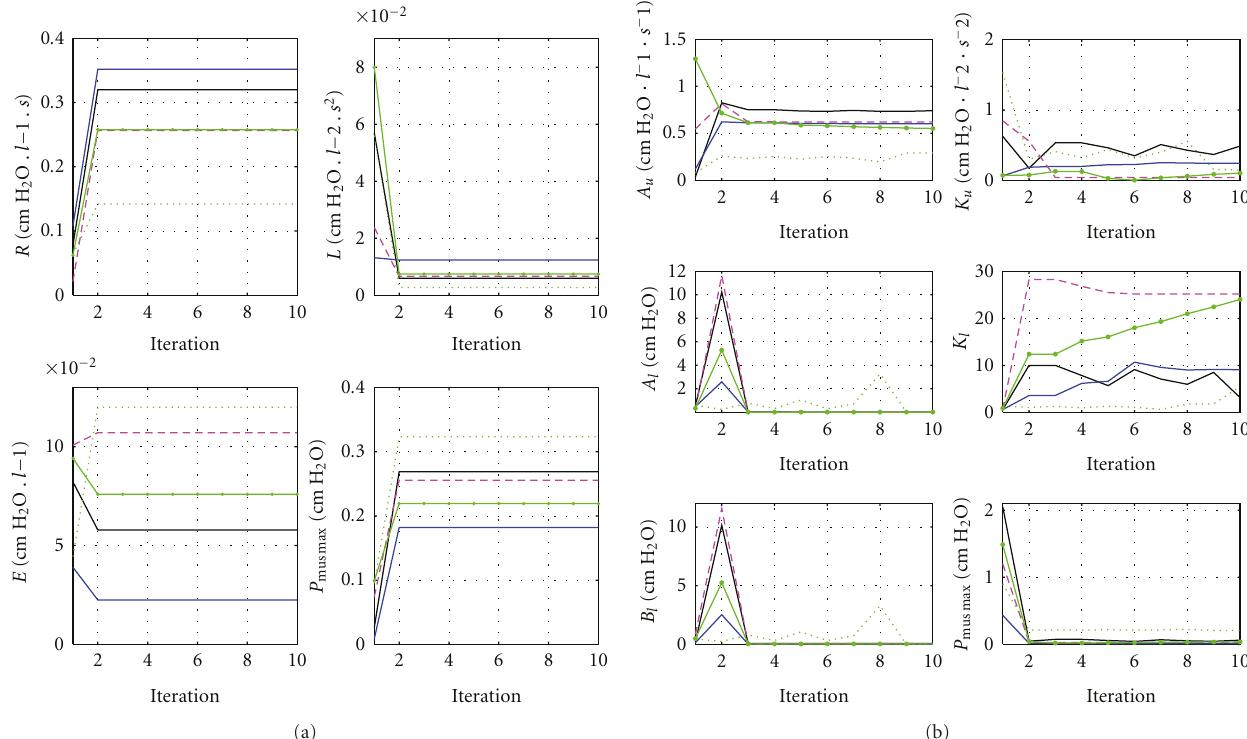
Figure 9: (a) Linear RIC model parameter estimation for five di ff erent breath cycles, produced by representative healthy subject’s signals. (b) Nonlinear model parameter estimation for five di ff erent breath cycles, produced by representative healthy subject’s signals.